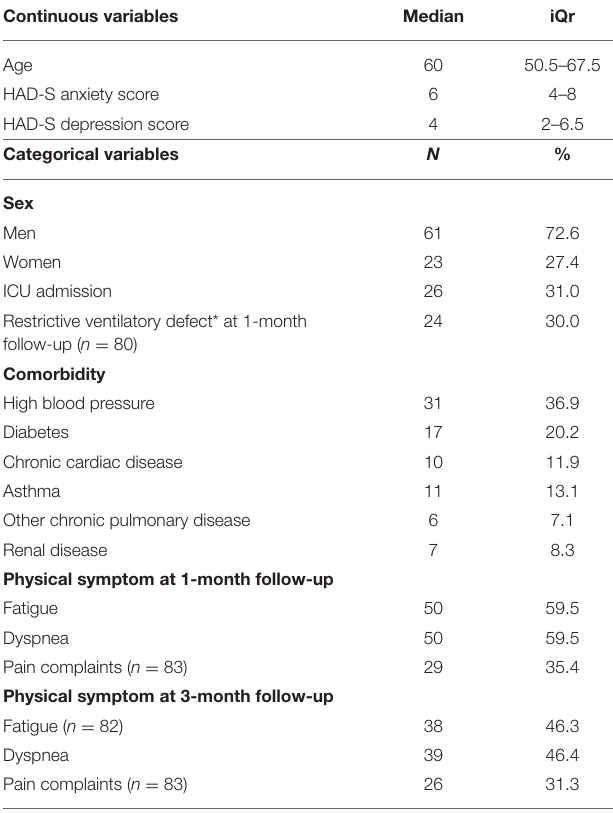
TABLE 2 | Factors associated with fatigue (model 1), dyspnea (model 2), and pain complaints (model 3) at 3-month follow-up in multivariable * logistic regression.